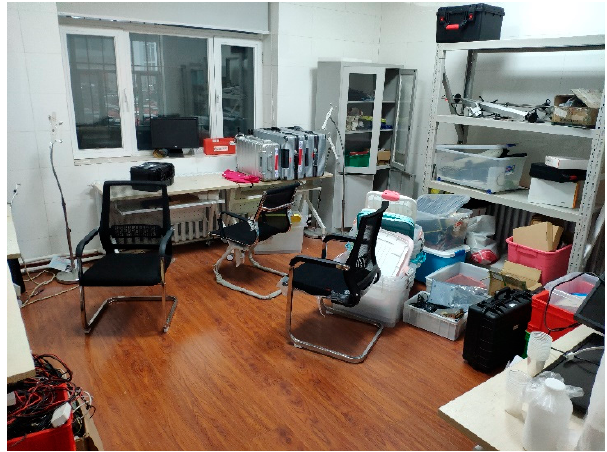
Figure 12. Scanned room in the indoor experiment.